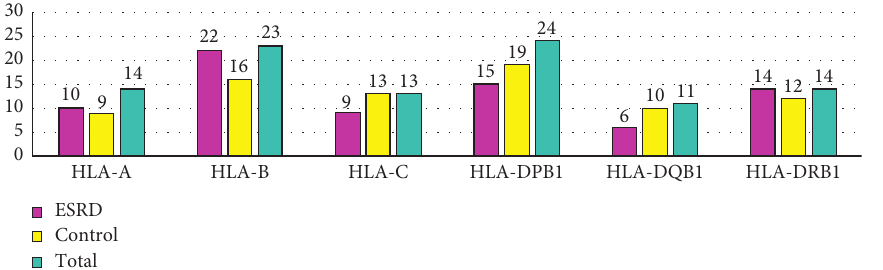
Figure 1: Numbers of HLA-A, HLA-B, HLA-C, HLA-DPB1, HLA-DQB1, and HLA-DRB1 allele groups in ESRD patients, control, and both groups. Table 1: HLA class I allele